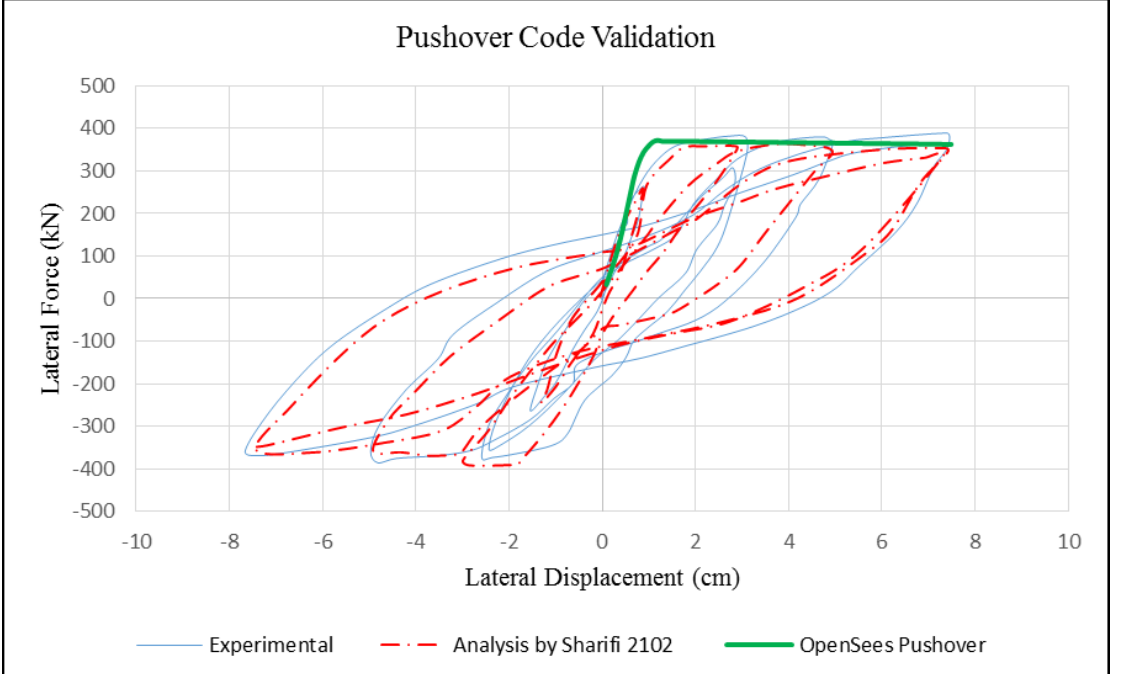
Figure 1. OpenSees code validation (Tanaka and Park test #5 (1990)).